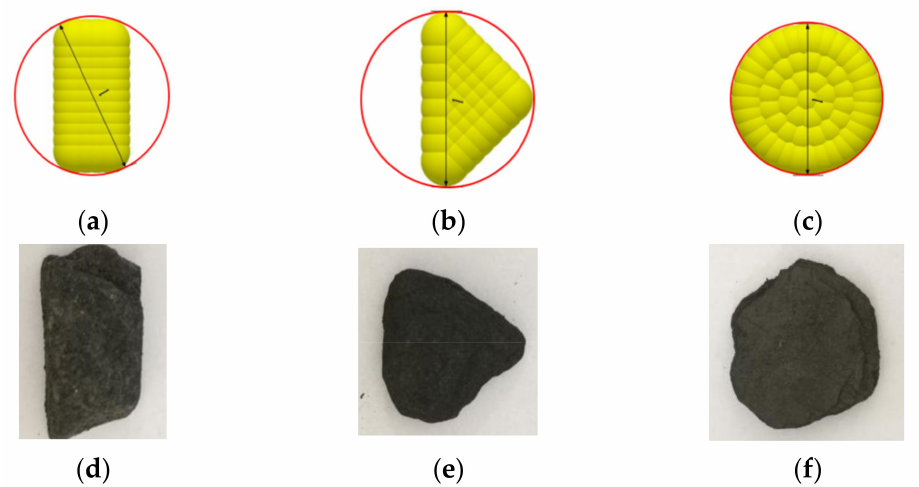
Figure 2. Flake particle model. ( a ) Rectangular flake particles; ( b ) triangular flake particles; ( c ) circular flake particles; ( d ) actual rectangular flake particles; ( e ) actual triangular flake parti- cles; ( f ) actual circular flake